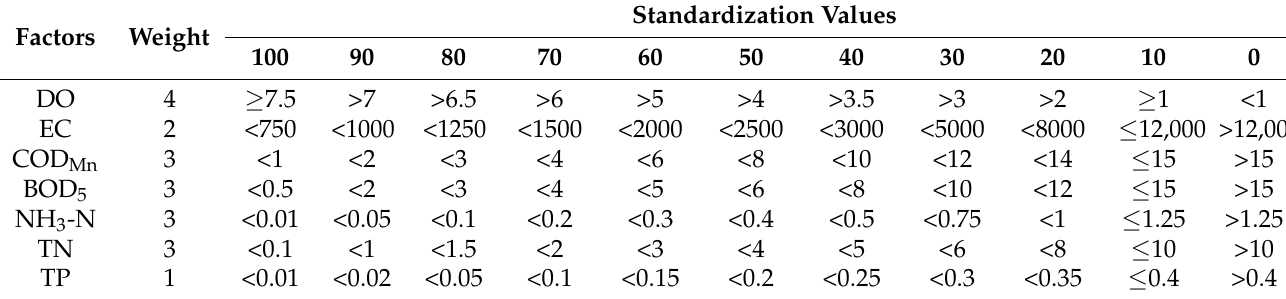
Table 5. Scores and weights of water quality factors in WQI